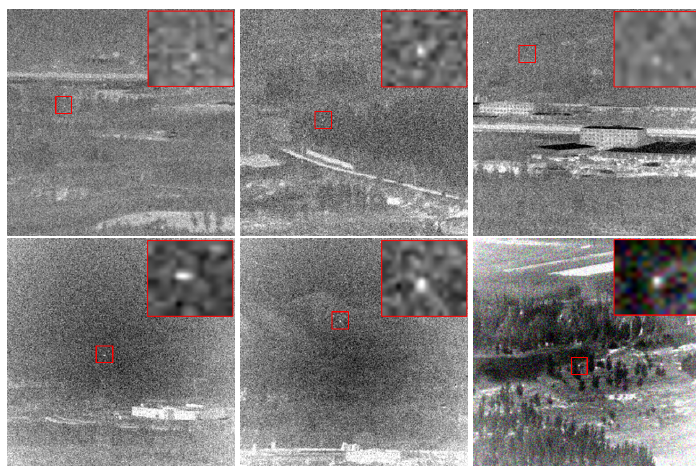
Figure 22. The images added noise with mean 0 and variance 0.01.